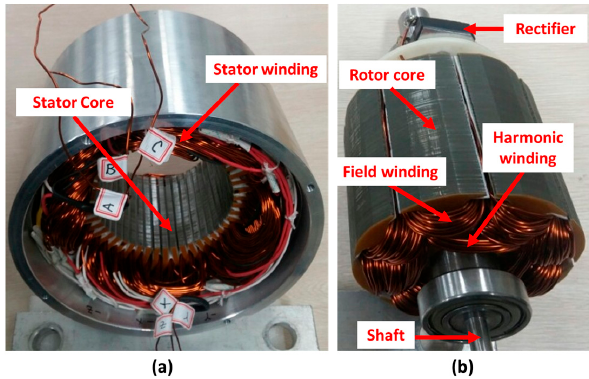
Figure 17. Variation of voltage with speed: ( a ) waveform; and ( b ) peak values.